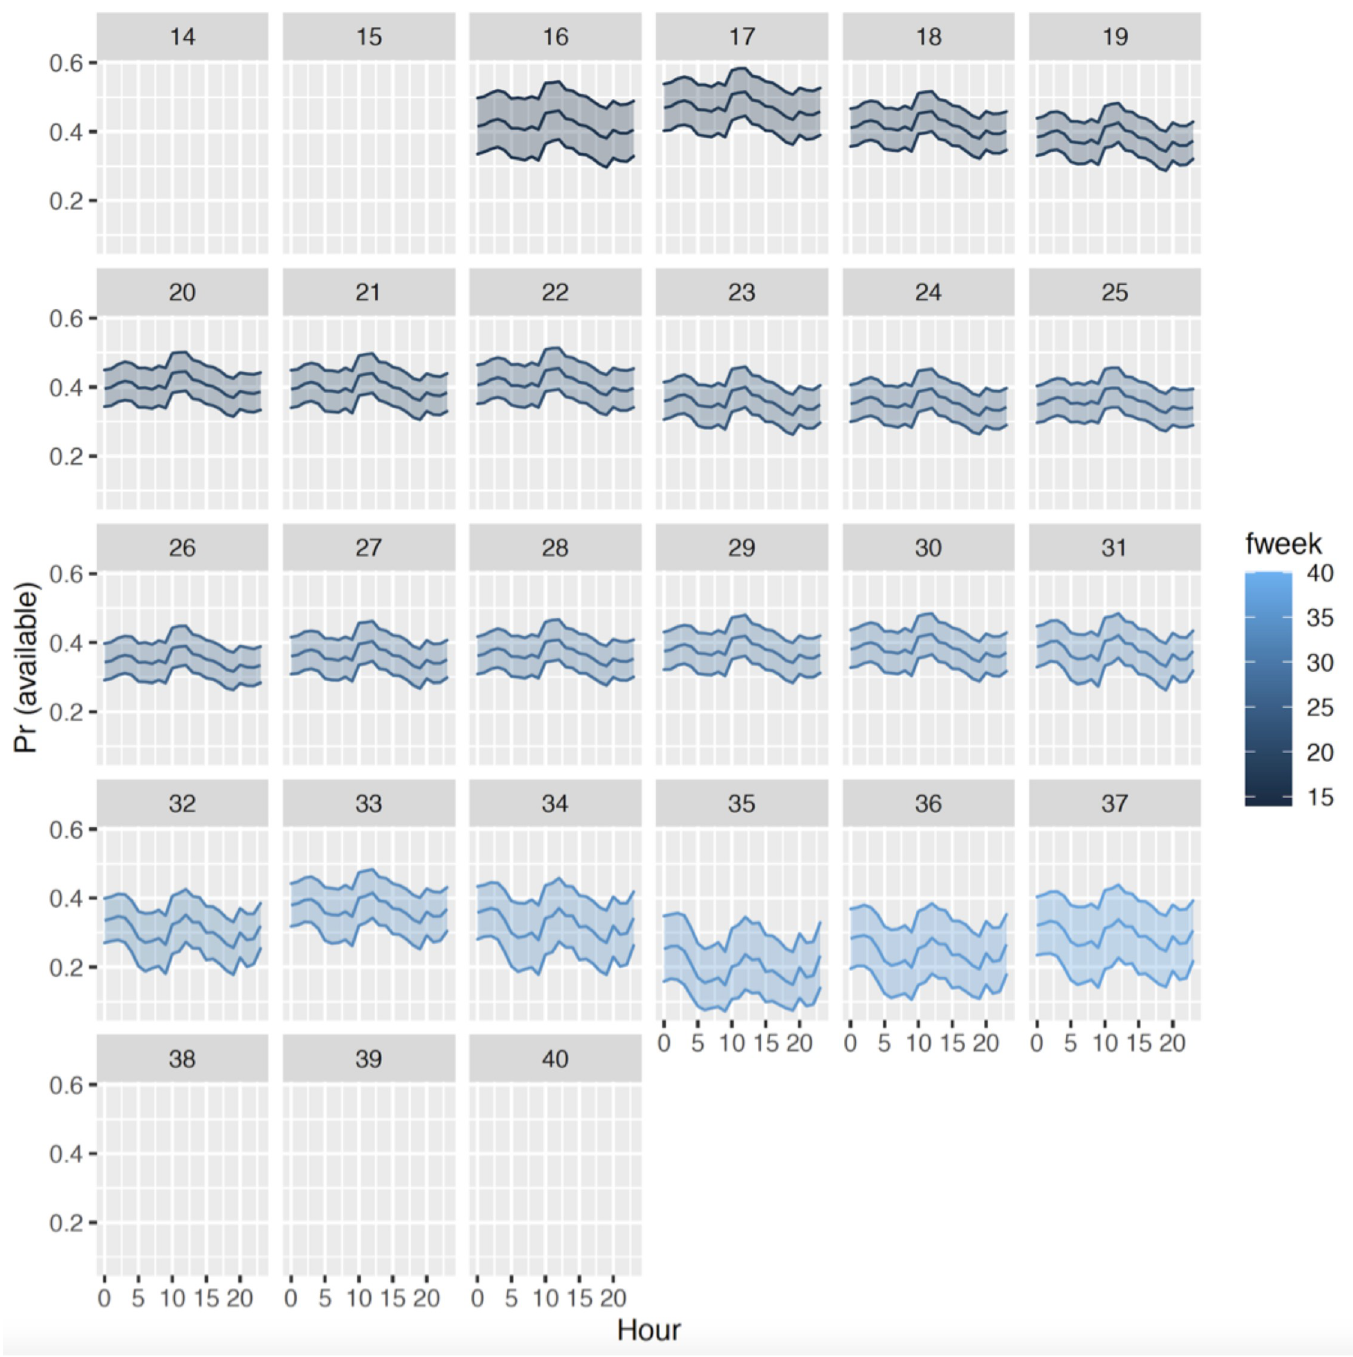
Fig 3. Modeling results of the proportion of seals available to be detected on aerial surveys, shown by week of the year, and time of day. Week numbers 16–21 correspond to spring, 22–34 correspond to summer, and 35–37 correspond to